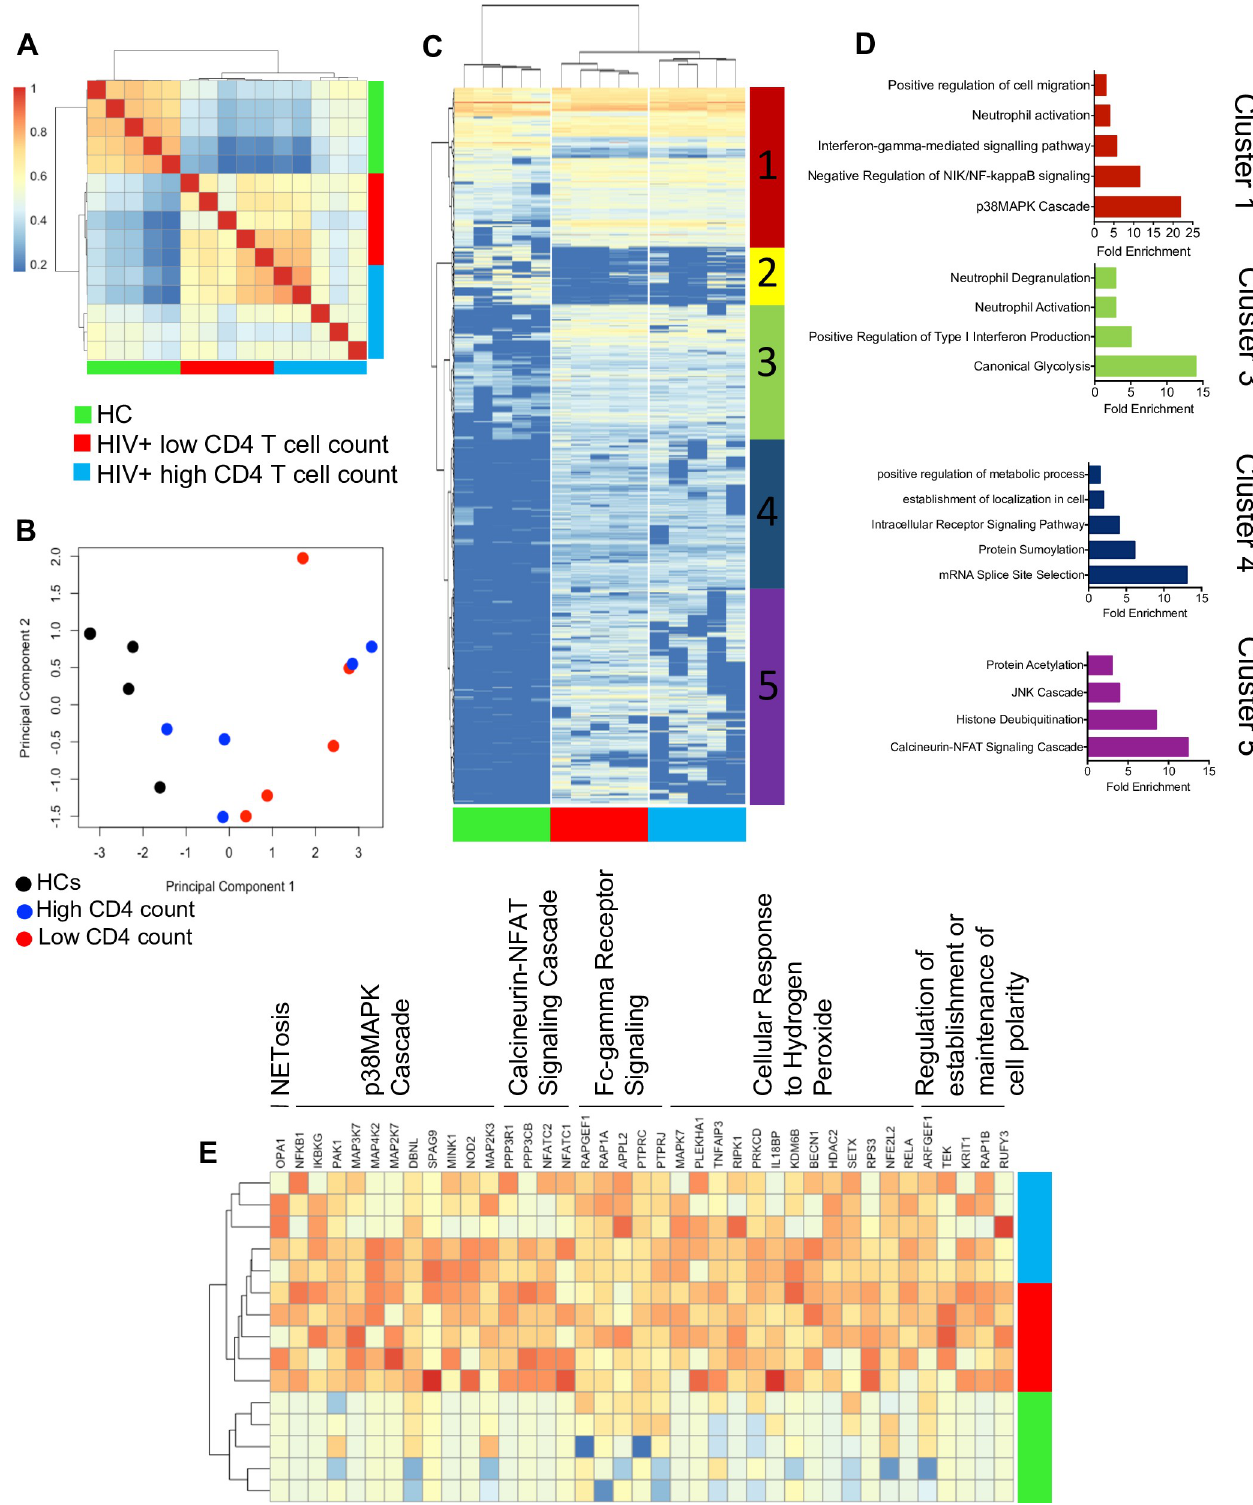
Fig 1. Neutrophils from HIV-infected individuals have a transcriptionally activated phenotype. (A) Correlation heatmap representing DEGs in neutrophils from HCs, HIV patients with high and low CD4 T-cell count. (B) PCA plot representing the differences between HIV-infected patients with high and low CD4 T-cell count or HCs. (C) A clustered heatmap showing the differences between individual genes between HIV patients with low and high CD4